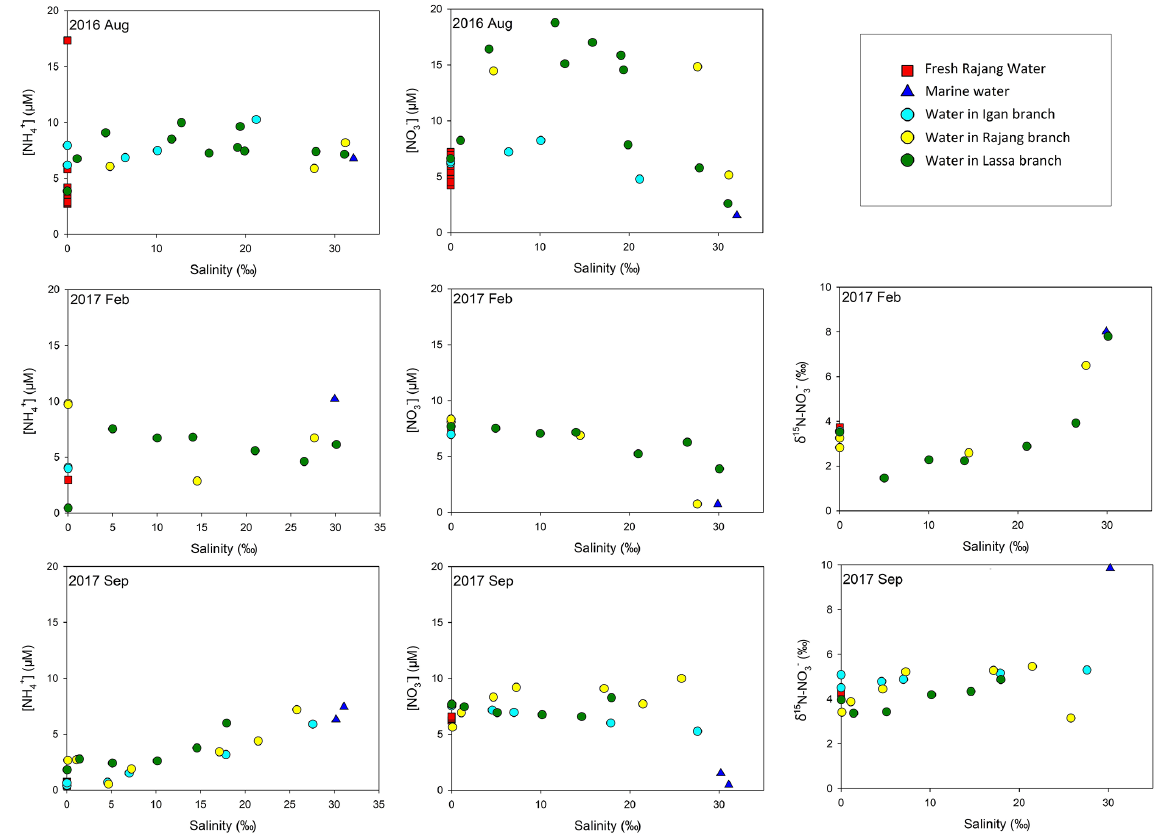
Figure 4. Distribution of NH +